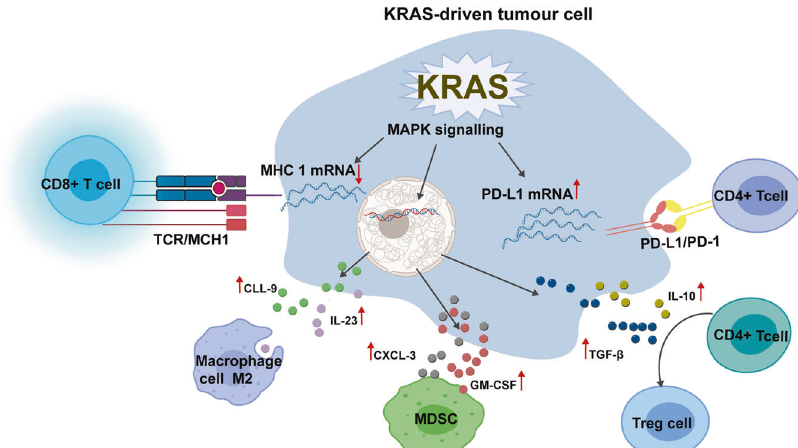
Fig. 4 KRAS-mediated immune escape in tumour microenvironment. KRAS mediates immune escape in the tumour macroenvironment by upregulating PD-L1expression, downregulating MHC1expression of tumour cells, and enhancing the secretion of a variety of cytokines and chemokines to recruit immunosuppressive immune cells. The black arrow represents facilitation, and the opposite red arrow represents inhibition. MDSCs: myeloid-derived suppressor cells; Treg cells: regulatory T cells; IL-10: interleukin-10; TGF- β : transforming growth factor- β ; GM-CSF: granulocyte-macrophage colony-stimulating factor; IL-23: